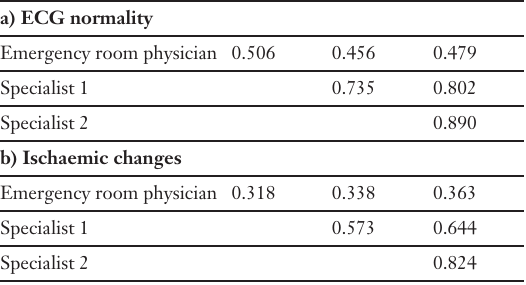
Distribution of ischaemic ECG changes between emergency physi- cians and final specialist interpreta- tion for patients with suspected